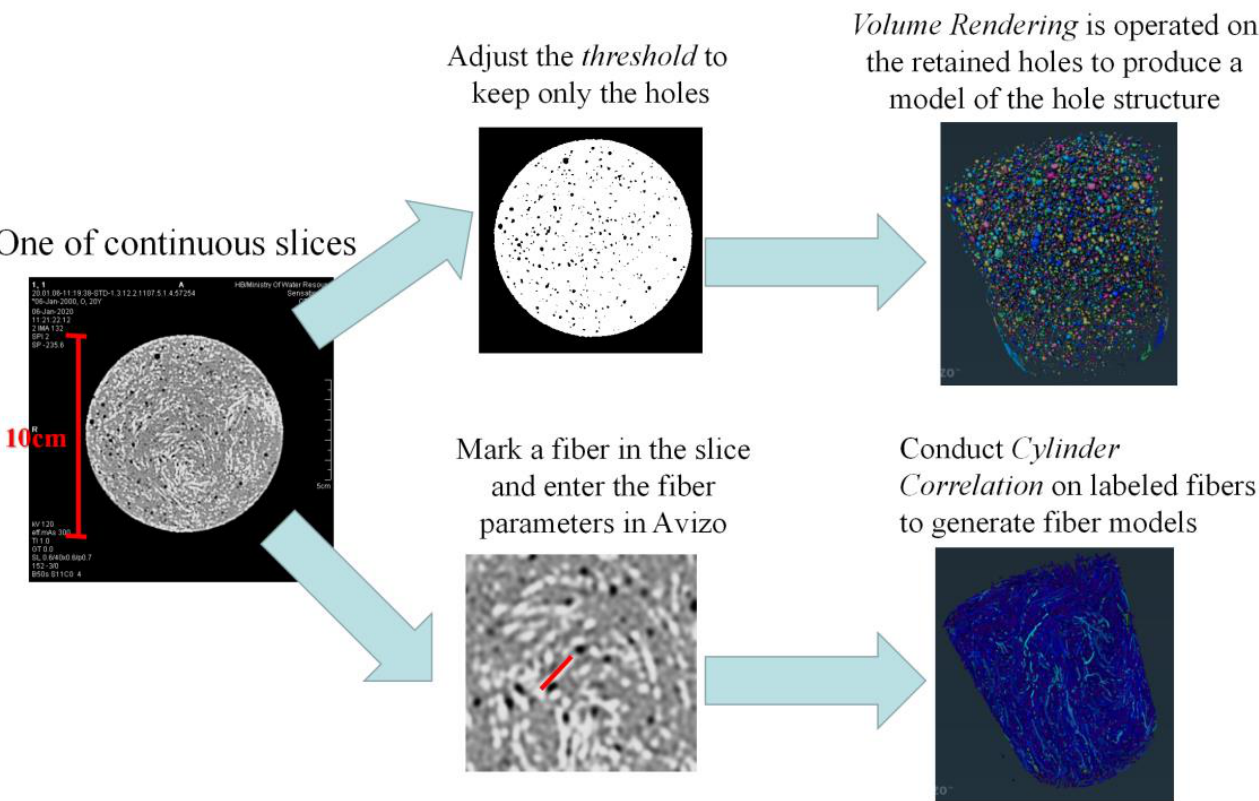
Figure 2. Schematic diagram of the pore and fiber structure reconstruction modeling.